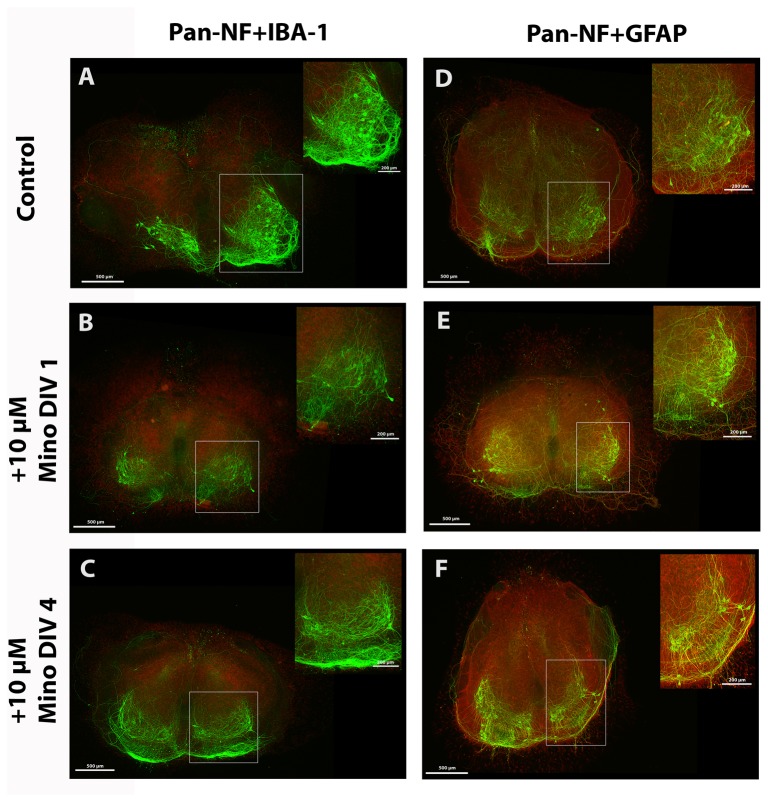
Fluorescence images of spinal cord cultures treated with 10 µM minocycline.Fluorescent images of spinal cord cultures of control (A, D) and of slices incubated with 10 µM minocycline from DIV 1 (B, E) and from DIV 4 (C, F) onwards. Slices were co-stained for anti-pan-NF (green) and anti-IBA-1 (red) in (A, B, C) or for anti-pan-NF (green) and anti-GFAP (red) in (D, E, F) at DIV 7. Motor neuronal areas are magnified and marked with a box. Control cultures show various anti-pan-NF stained motor neurons, neurons, modest microglia activation (A) and formation of a glia cover (B). All cultures treated with minocycline show control-like staining patterns. No clear differences in the staining pattern are visible. Bars = 500 µm, bars in magnified area = 200 µm.